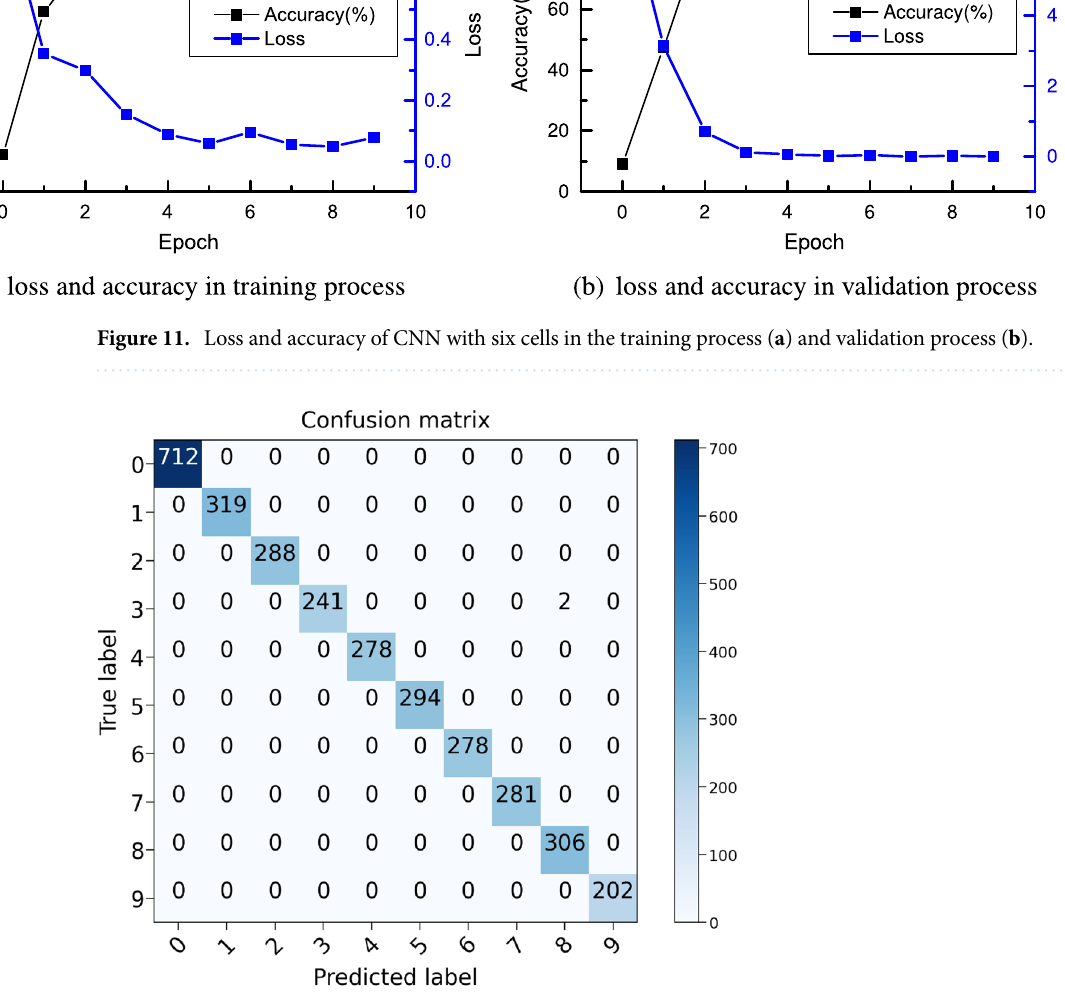
Figure 12. Test confusion matrix of CNN with six